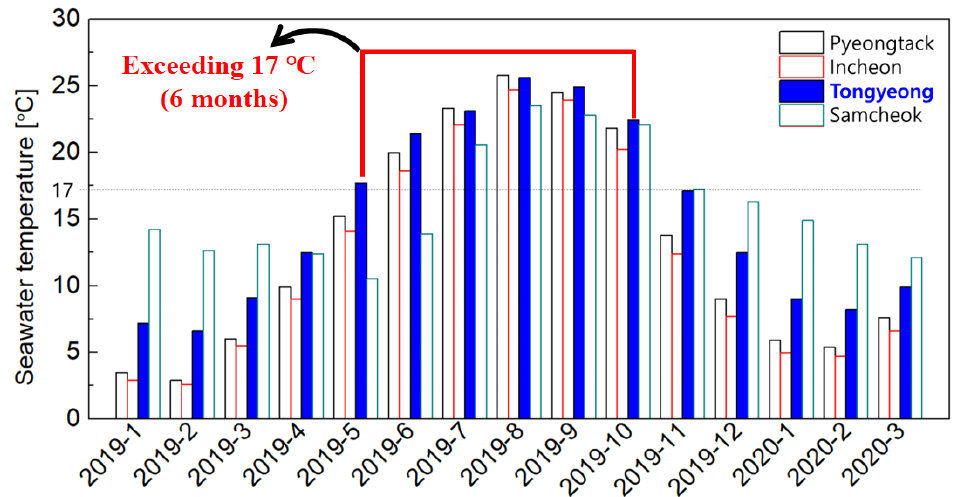
Figure 1. Temperature of seawater near LNG receiving terminals in South Korea from 2019 to 2020 [19].